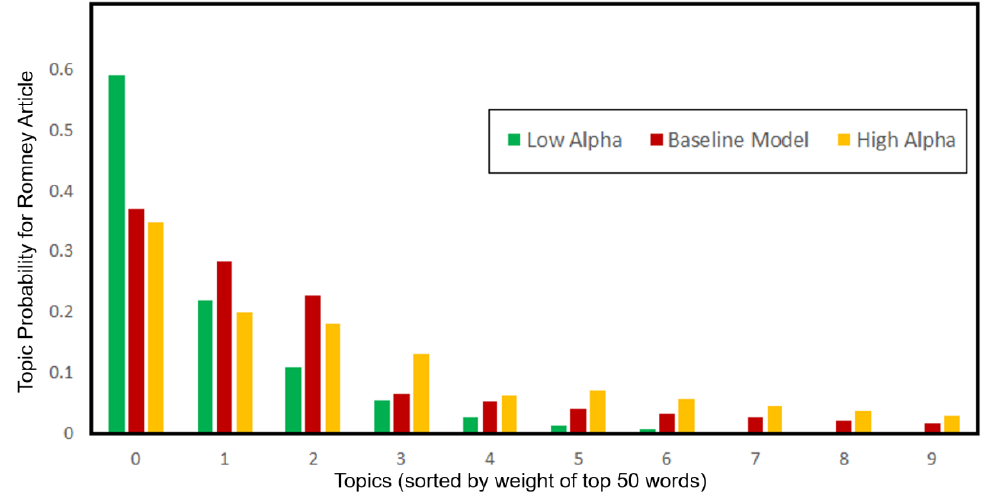
Figure 2. Smoothing impact of LDA hyperparameter Alpha.